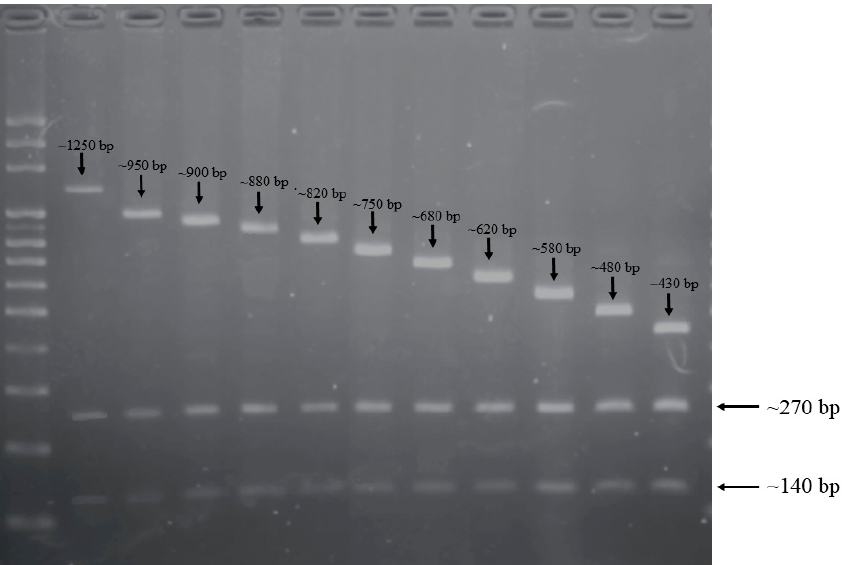
Figure 1. Restriction fragment length polymorphism (RFLP) results of CRISPR1 from 103 CC17/III GBS isolates. The length of CRISPR1 sequences after restriction enzyme digestions ranged from 140 to 1250 bp. The 140 and 270 bp fragments existed in all CC17/III GBS isolates, and the third fragment with spacers had lengths ranging from 430 to 1250 bp.